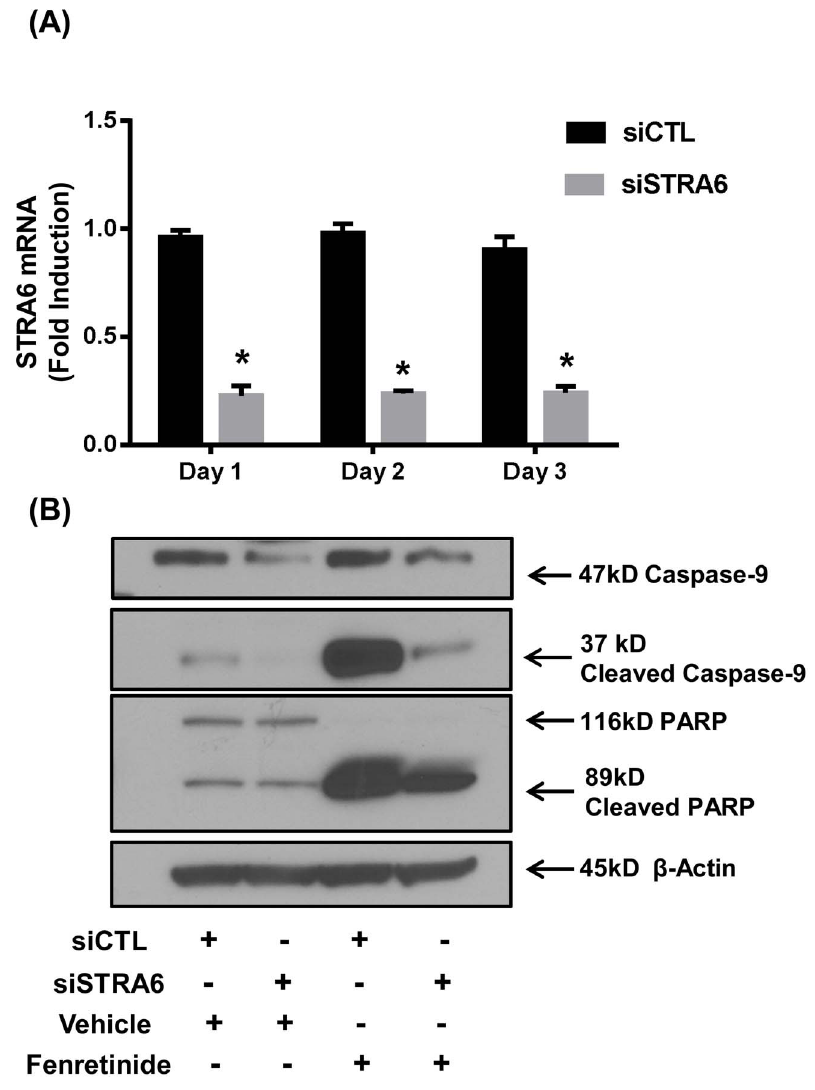
Figure 4. Inhibition of fenretinide induced apoptosis by knockdown of STRA6 gene expression. Ishikawa cells were transfected with 30 nM siCTL (nontargeting negative control siRNA) or siSTRA6. ( A ) Total RNA was isolated from untreated Ishikawa cells at 3 consecutive days of